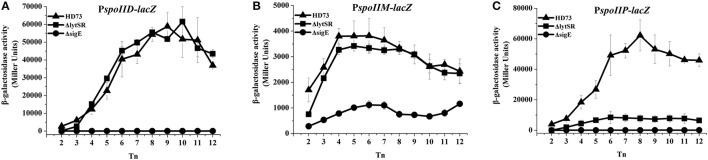
Transcription of PspoIID, PspoIIM, and PspoIIP promoters in Bt. Transcription of PspoIID
(A), PspoIIM
(B), and PspoIIP
(C) in wild-type HD73 (▴), lytSR mutant (■), and sigE mutant (•) cells grown in SSM. T0 is the end of the exponential phase, and Tn is n hours after T0. Values represent the means of at least three independent replicates; error bars represent standard deviations.